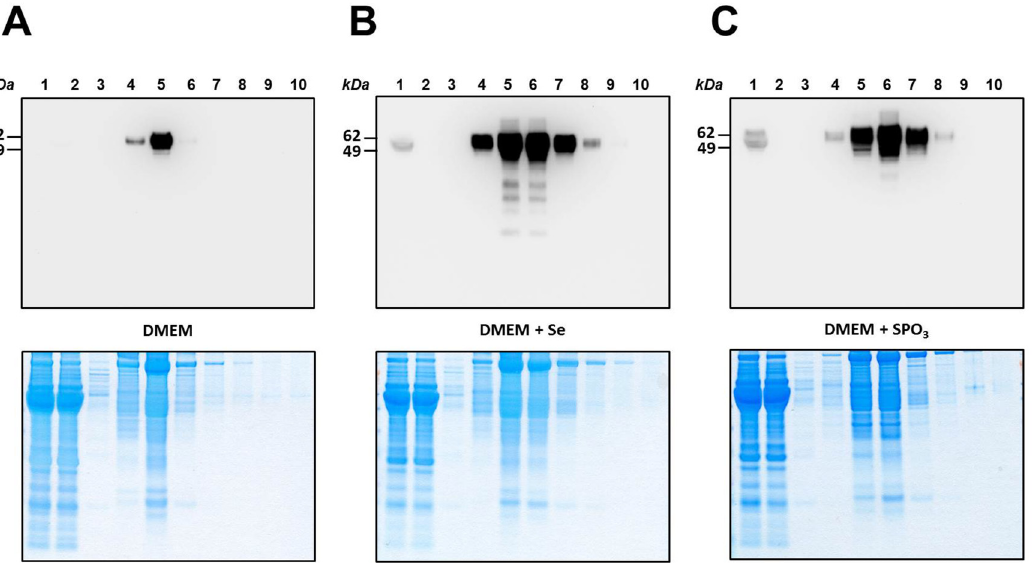
Fig 3. Isolation of SelP from culture media of HepG2 cells. Medium samples from HepG2 cells were chromatographed on HisPur resin. Fractions were analyzed by SDS-PAGE, the gels stained with Coomassie blue ( Lower panels ) and subjected to Western blotting with anti-SelP antibodies ( Upper panels ). Lane 1 , initial sample, lane 2 , flow-though fraction, lane 3 , buffer wash, lane 4 – 10 , elution with a gradient of imidazole from 0 to 200 mM in loading buffer. (A) HepG2 cells grown on DMEM medium only (control). (B) HepG2 cells grown on DMEM supplemented with 100 nM Se. (C) HepG2 cells grown on DMEM supplemented with 1 mM thiophosphate (SPO 3 ). Protein molecular weights markers in kDa are shown on the left . Experimental details are given in Materials and Methods .